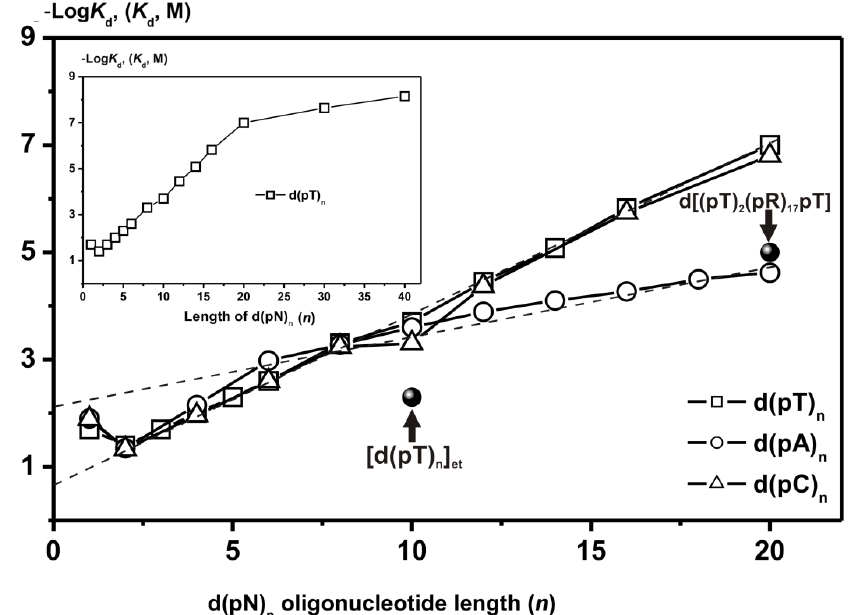
Figure 10. Dependencies of −Log K d for ss and ds d(pN) n deoxyribooligonucleotides versus their length ( n ) in the case of the second site of RecA protein [86–88]. For comparison, the inset shows the Log-dependences of the K d values characterizing the affinity of the first site of the RecA filament to d(pT) n . All types of ODNs including those containing not many bases [d(pT) 2 (pR) 17 pT]) and completely ethylated at internucleoside phosphate groups ([d(pT) n ] et are shown on the Panel.